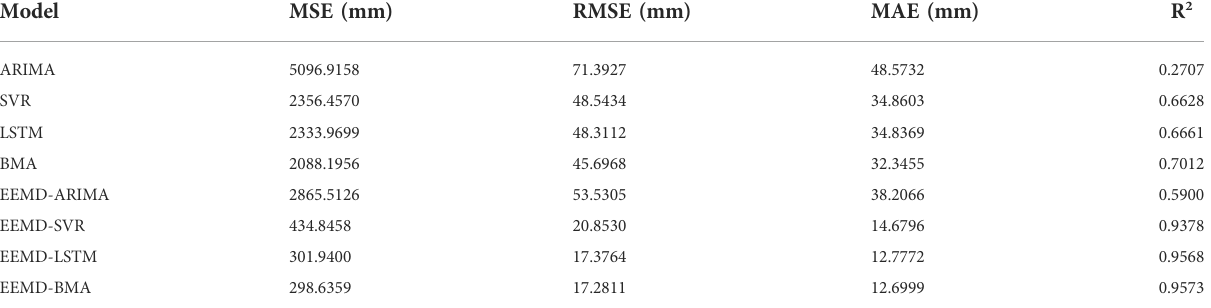
TABLE 4 Performances of different models.